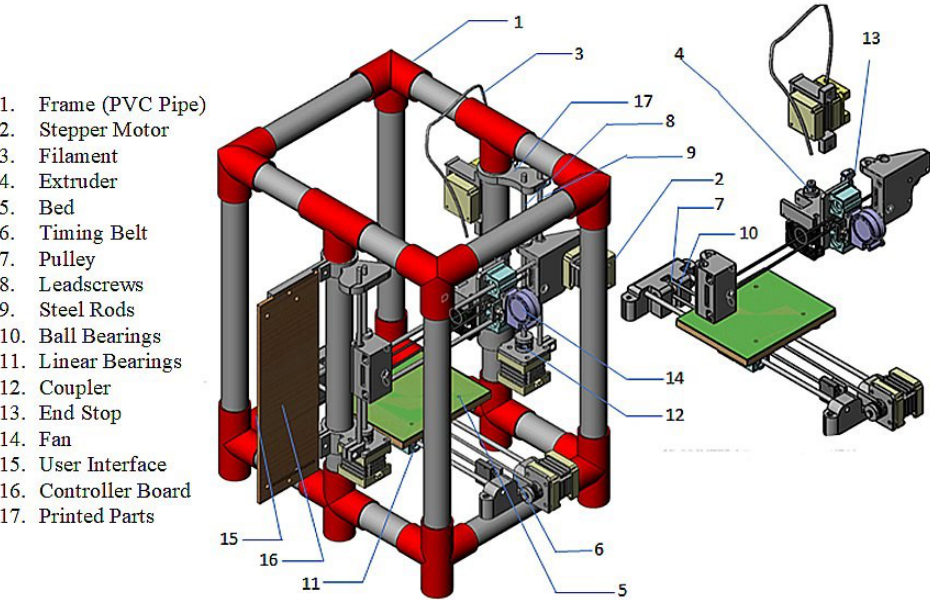
Figure 2. The isometric view of the 3D printer CAD model .